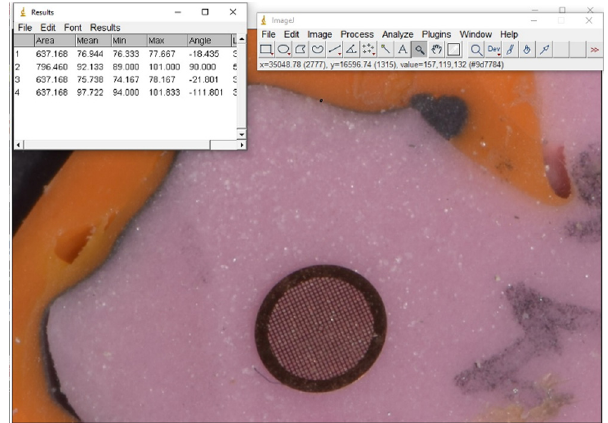
Figure 1. Measurements of silicon replica with ImageJ software (NIH, Bethesda, MA, USA).